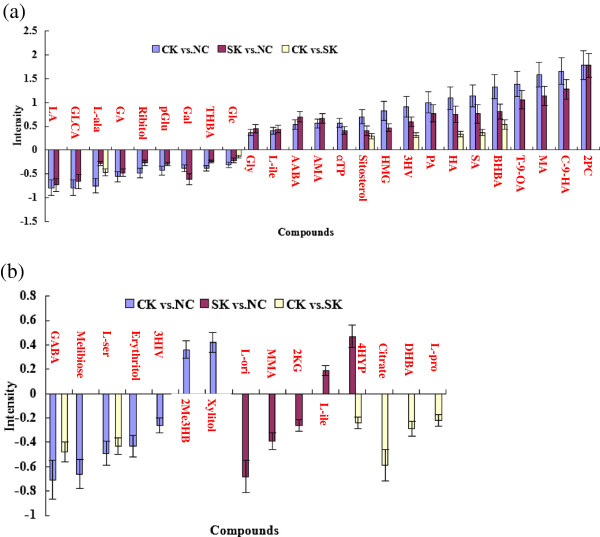
Intensity of metabolites from CK compared to NC (blue column), SK compared to NC (red column), and CK compared to SK (yellow column). (a) Expression intensity of 25 identical metabolites from CK vs. NC and SK vs. NC, including 7 metabolites from CK vs. SK. 2PC, 2-piperidinecarboxylic acid; C-9-HA, cis-9-hexadecenoic acid; MA, myristic acid; T-9-OA, Trans-9-octadecenoic acid; BHBA, 3-hydroxybutyric acid; SA, stearic acid; HA, heptadecanoic acid; PA, palmitic acid; 3HV, 3-hydroxyvaleric acid; HMA, 3-hydroxy-3-methylglutaric acid; VE, vitamin E (α-tocopherol); AMA, aminomalonic acid; AABA, α-aminobutyric acid; L-ile, l-isoleucine; Gly, glycine; Glc, Glucose; THBA, 2,3,4-trihydroxybutyric acid; Gal, galactose; pGlu, pyroglutamic acid; GA, glycolic acid; L-ala, l-alanine; GLCA, glucuronic acid; LA, lactic acid. (b) Expression intensity of 15 different metabolites from three groups. GABA, 4-aminobutyric acid; L-ser, l-serine; 4HYP, 4-hydroxyproline; 3-HIV, 3-hydroxyisovaleric acid; 2Me3HB, 2-methyl-3-hydroxybutyric acid; L-orn, l-ornithine; MMA, methylmalonic acid; 2-KG, 2-ketoglutaric acid; L-leu, l-leucine; Cit, citrate; DHB, 3,4-dihydroxybutyric acid; L-pro, l-proline.